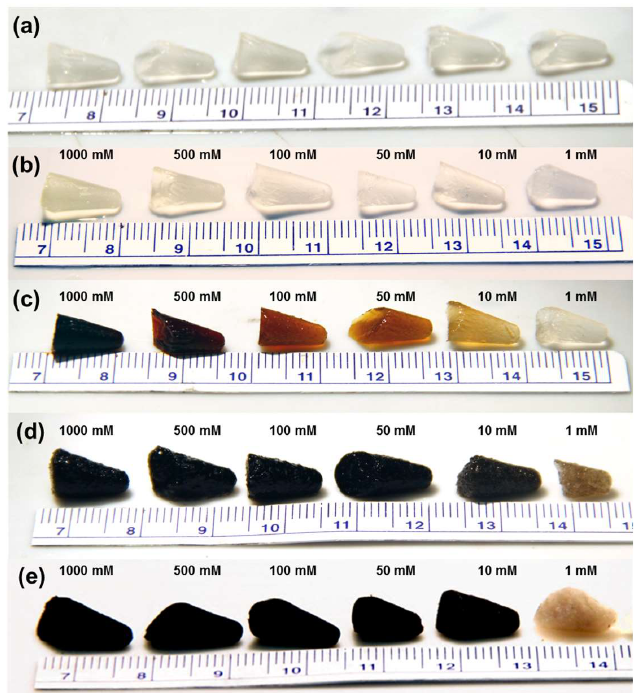
Figure 2. Aerogel synthesis process photos. ( a ) cross linked carboxymethyl cellulose nanofiber hydrogels with EDC and ethylenediamine as a linker molecule. CNF hydrogels equilibrated with palladium salt solutions of 1, 10, 50, 100, 500, and 1000 mM for ( b ) Pd(NH 3 ) 4 Cl 2 , and ( c ) Na 2 PdCl 4 ; ( d )